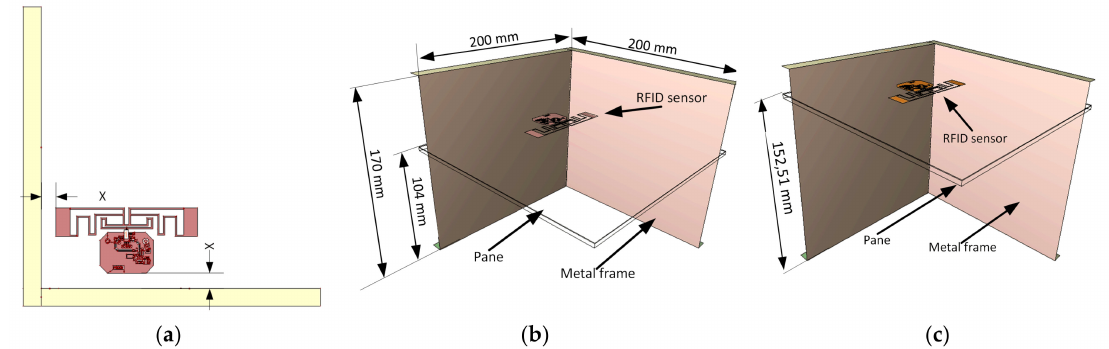
Figure 18. Considered cases of RFID antenna and frame unit arrangements: ( a ) Separation x = 10 mm, 20 mm, 30 mm, 40 mm, 50 mm, 60 mm, 70 mm, 80 mm; ( b ) RFID antenna on the inner pane No.1 ( c ) RFID antenna on the outer pane No.2.